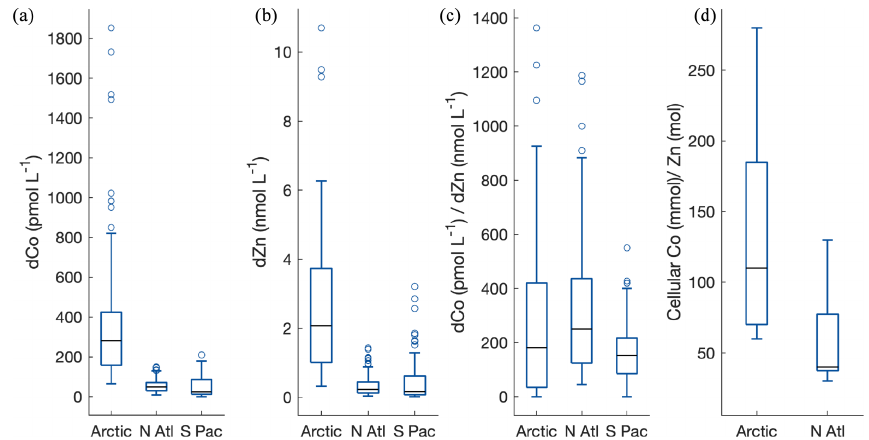
Figure 16. Median dCo concentrations (a) , dissolved Zn concentrations (b) , and dCo / dZn ratios (c) in the upper 200m in the Arctic (this study), North Atlantic (Noble et al., 2017), and the southern eastern Pacific (Hawco et al., 2016). (d) Co / Zn ratios in phytoplankton from the Arctic and North Atlantic. Whiskers represent the lower (25%) and upper (75%)